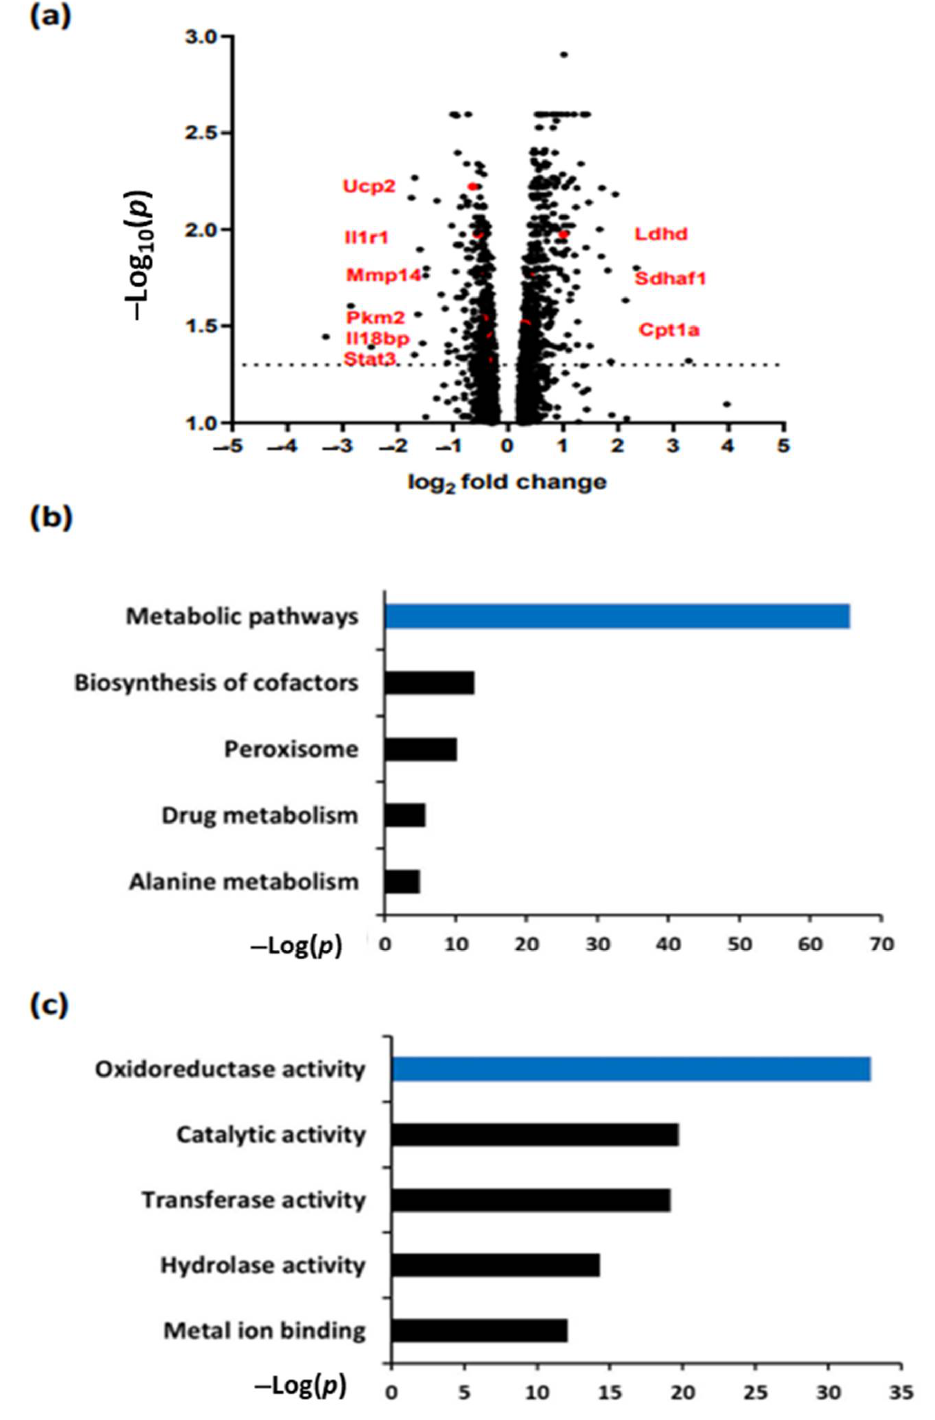
Figure 1. aPC regulates metabolic pathways and oxidoreductase activity in DKD. ( a ) Volcano plot showing differentially expressed genes (DEGs) in APC high -DM mice compared with WT-DM mice. Example genes related to metabolism and inflammatory pathways are shown in red (bold). ( b ) KEGG pathway analysis of renal (induced) DEGs enriched by DAVID in APC high -DM mice compared to WT-DM mice. The bar plot shows the enrichment scores (-log [ p value]) of the significantly enriched KEGG pathways. ( c ) KEGG pathway analysis of metabolism-related DEGs enriched by DAVID in APC high -DM mice compared to WT-DM mice. The bar plot shows the enrichment scores ( − log [ p value]) of the significantly enriched KEGG